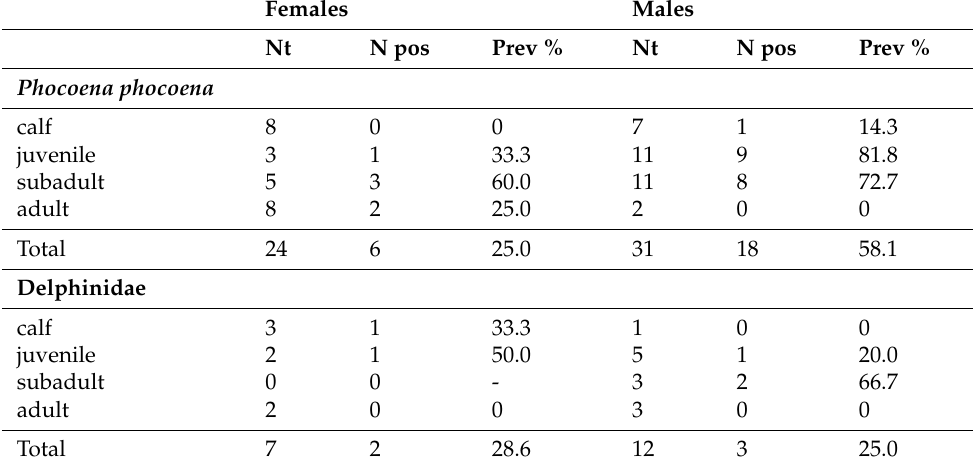
Table 2. TSD prevalence levels (Prev) in Phocoenidae and Delphinidae stranded along the Californian coast in 2018–2021. Abbreviations are: Nt = total number; N pos = number of individual positives with tattoo skin disease, as determined by visual examination and, in four cases, also by histology. Females